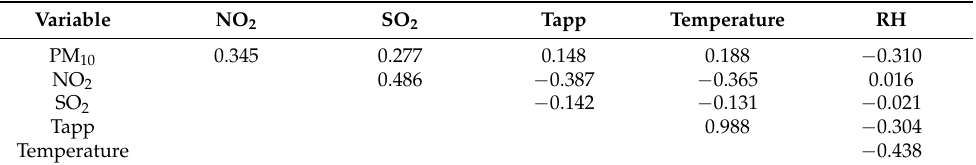
Table 2. Spearman rank correlation coefficients between air pollution and weather variables in Cape